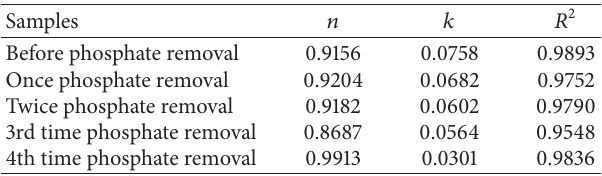
Figure 2: Nitrogen adsorption-desorption isotherms of amorphous ceramics before and after removing phosphate. Table 2: The correlate constants for the Avrami kinetic equation describing Ca 2+